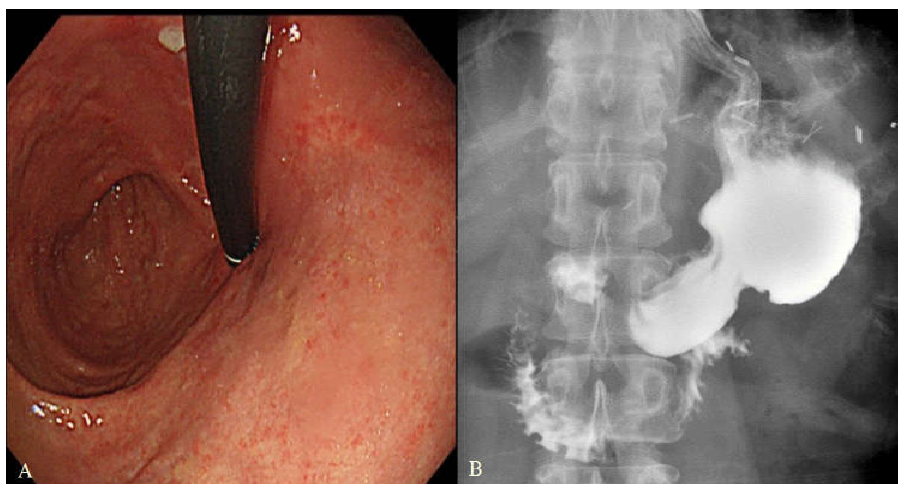
Figure 2. Postoperative endoscopic finding and upper gastrointestinal series after SPADE operation. ( A ) Endoscopic finding showing artificial His angle and pseudo-fornix. ( B ) Upper gastrointestinal series after SPADE method. Table 2. Postoperative endoscopic findings and reflux symptom in 1 year